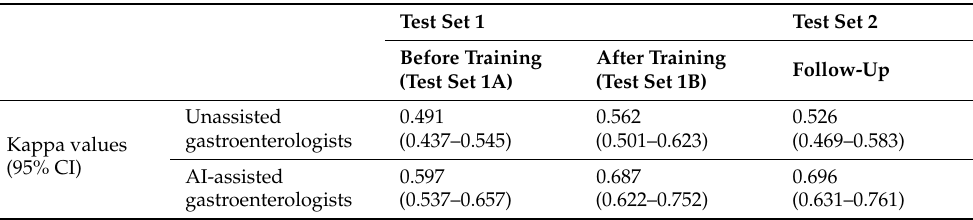
Table 3. Interobserver agreement for interpretation of endocytoscopic BE images for unassisted and AI-assisted gastroenterologists at various testing